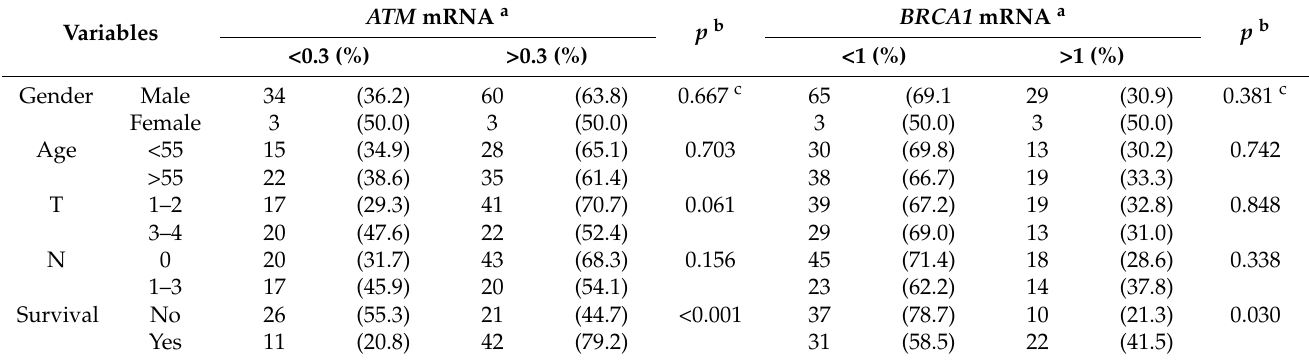
Table 2. Correlation between clinicopathological variables and mRNA expression.